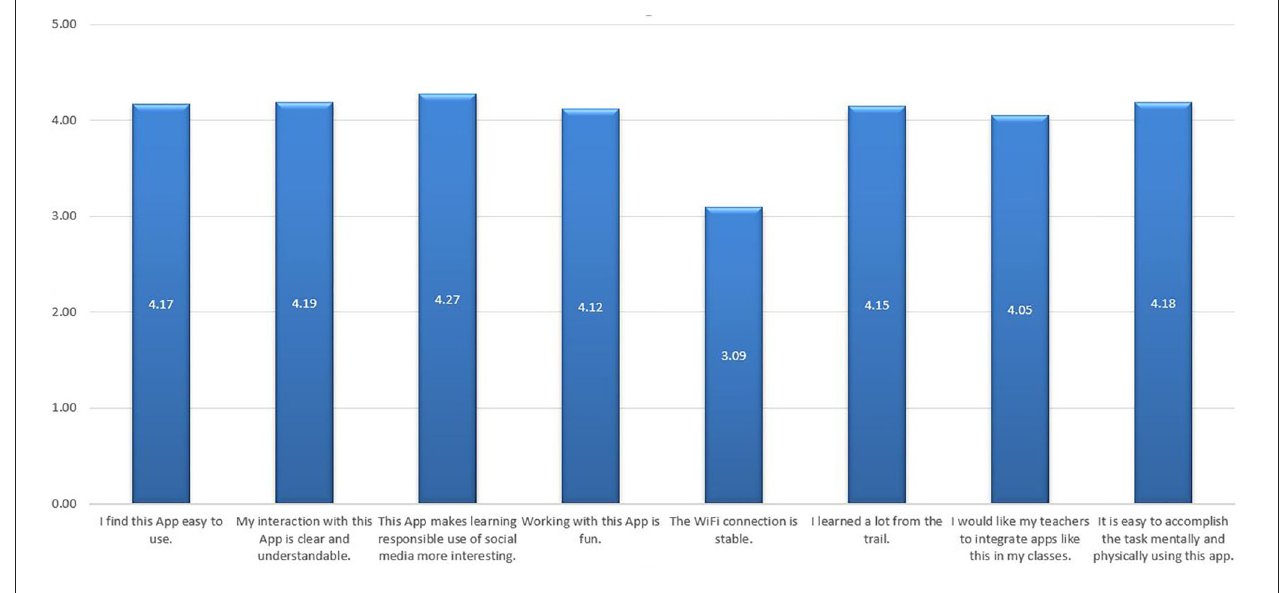
FIGURE 9 | Survey Evaluation.